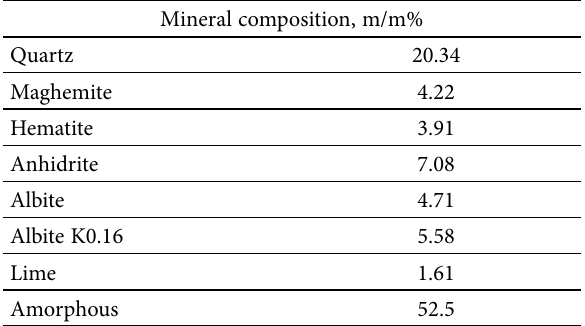
Table 2. Phase composition of raw fly ash Mineral composition, m/m%